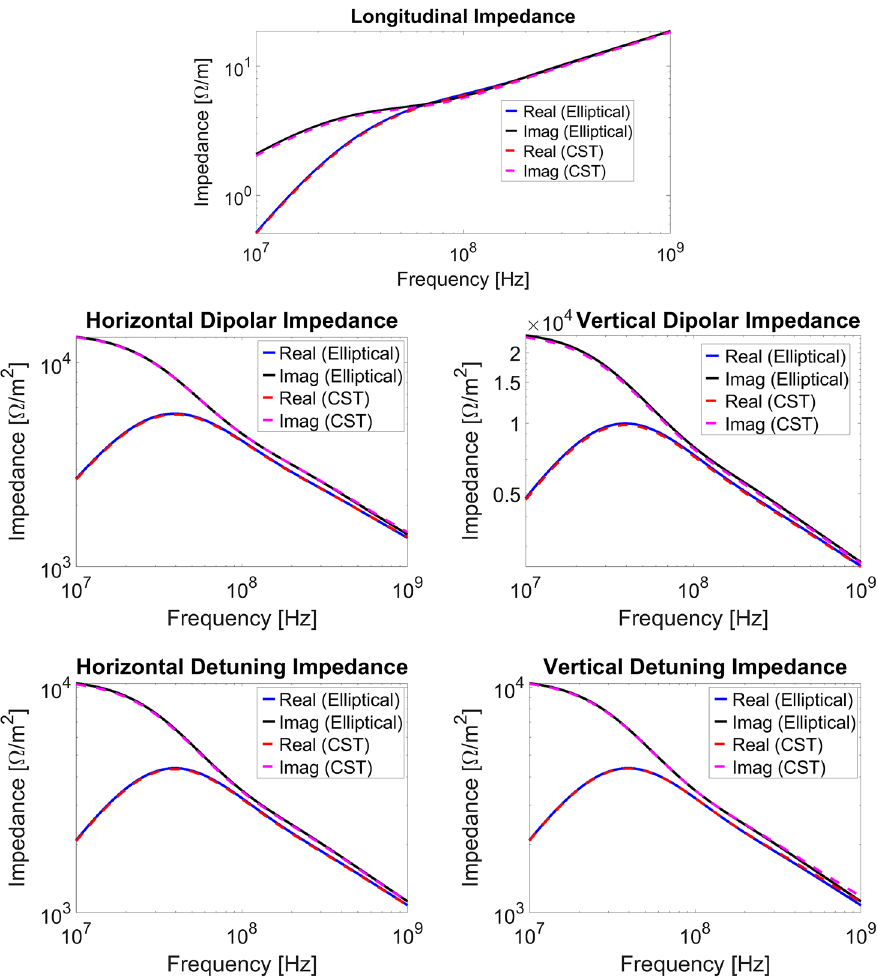
FIG. 4. Coupling impedances per unit of length as given by Eqs. (26) – (30) compared to the results of CST . The beam pipe has a first layer with σ ¼ 400 S = m and thickness of 5 mm, followed by a perfect electric conductor. The relativistic factor is γ ¼ 27 . 7 and q ¼ 0 . 29 r